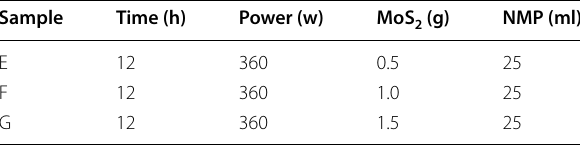
Table 1 Exfoliation of MoS nanosheets with different ultrasonic adsorbed on the surface of MoS 2 through non-covalent 2 power bonds. From Fig. 6b, it can be seen that bulk MoS 2 has been exfoliated into MoS 2 nanosheets when the mass of Sample Time (h) MoS 2 ( g) NMP (ml) MoS 2 powder is 1 g, and the lateral size is larger than that of Fig. 6a. When the mass of bulk MoS 2 is 1.5 g, NMP is not enough to weaken the van der Waals force between MoS 2 layers, so the exfoliated MoS 2 nanosheets are thicker and multi-layered MoS 2 nanosheets as shown in Fig. 6c. It indicated that the optimal mass of MoS 2 pow- der is 1.0 g when the NMP solvent has a volume of 25 ml. Optoelectronic Properties of CuNW/MoS CTCF 2 Table 2 The amount ratio of bulk materials and NMP solvent Although CuNW TCF have many advantages, some fatal Sample Time (h) Power shortcomings cannot be ignored, including high rough- ness, low chemical stability, and low work functions. In order to overcome these problems, CuNW/MoS 2 CTCF was prepared by spin coating MoS 2 solution on the sur- face of CuNW TCF to reduce roughness and increase